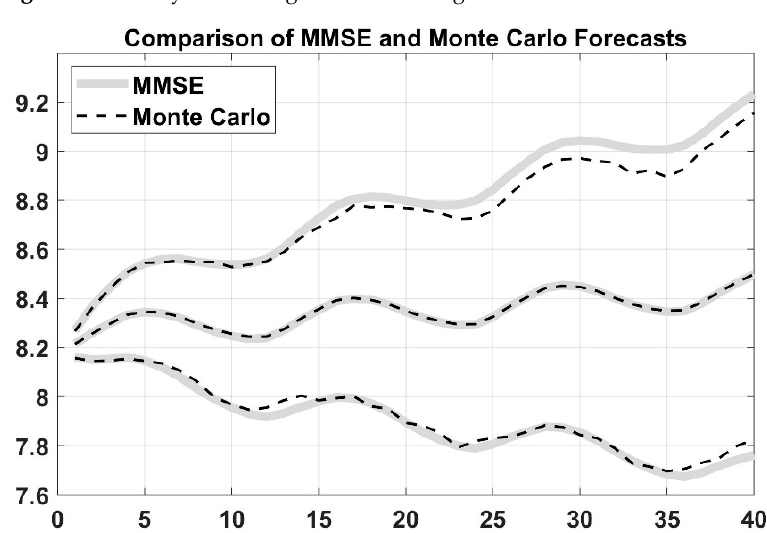
Figure 25. Per day forecasting validation using ARIMA.